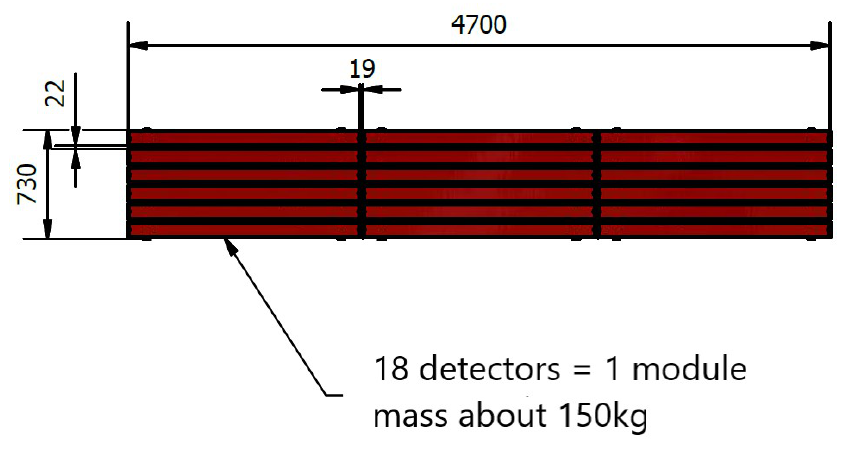
Figure 6. The MCORD detector modules consist of three sections, six scintillators each. The modules and sections can be separated from each other.